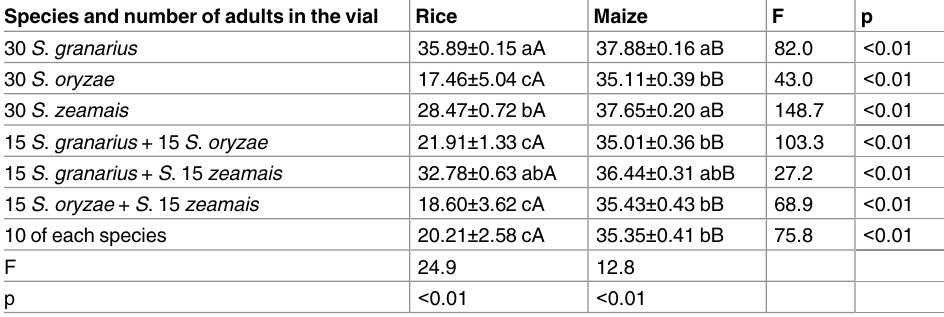
Table 6. Mean grain weight (g) ± SE per vial of the kernels without the frass in vials containing differ- ent combinations of S . granarius , S . oryzae and S . zeamais on rice or maize. Species and number of adults in the vial Rice Maize F p 30 S . granarius 35.89 ± 0.15 aA 37.88 ± 0.16 aB 82.0 < 0.01 30 S . oryzae 17.46 ± 5.04 c Α 35.11 ± 0.39 bB 43.0 < 0.01 28.47 ± 0.72 bA 37.65 ± 0.20 aB 148.7 < 0.01 15 S . granarius + 15 S . oryzae 21.91 ± 1.33 cA < 0.01 32.78 ± 0.63 abA 36.44 ± 0.31 abB 27.2 < 0.01 15 S . oryzae + S . 15 zeamais 18.60 ± 3.62 cA 35.43 ± 0.43 bB 68.9 < 0.01 10 of each species 20.21 ± 2.58 cA 35.35 ± 0.41 bB 75.8 < 0.01 F 24.9 12.8 p < 0.01 < 0.01 Within each column, means followed by the same lowercase letter are not significantly different (Tuckey- Kramer HSD test at p = 0.05; for rice df = 6, 37, for maize df = 6, 56). Within each row, means followed by the same uppercase letter are not significantly different (Tukey-Kramer HSD test at p = 0.05; df ranged between 1, 10 and 1,